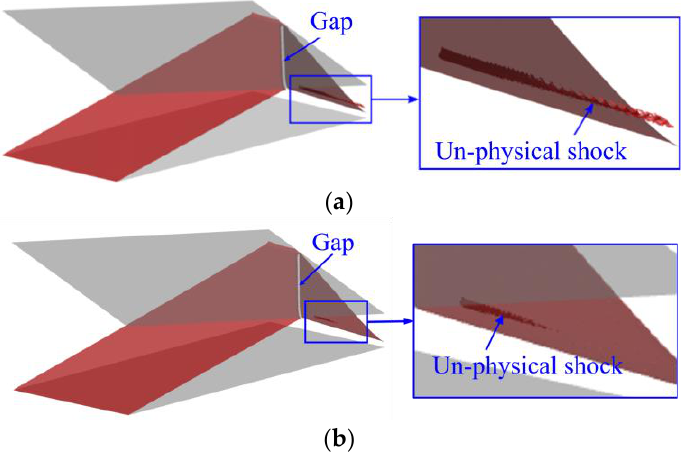
Figure 8. Shock waves detected by the traditional method with the filter parameter of ( a ) δ𝜌 ≥ 1000 and ( b ) δ𝜌 ≥ 2000, where the red and gray surfaces are the detected shock waves and walls, respectively.